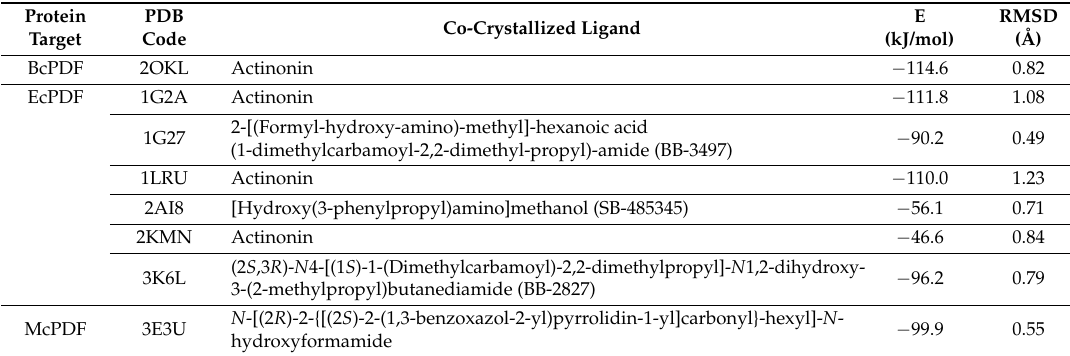
Figure 23. Acetylene, glucoside, and other miscellaneous phytochemicals examined in this work. Table 1. MolDock docking energies of co ‐ crystallized ligands and the root ‐ mean ‐ squared deviations between the co ‐ crystallized ligand and the re ‐ docked poses of the co ‐ crystallized ligand with bacterial protein target crystal structures.